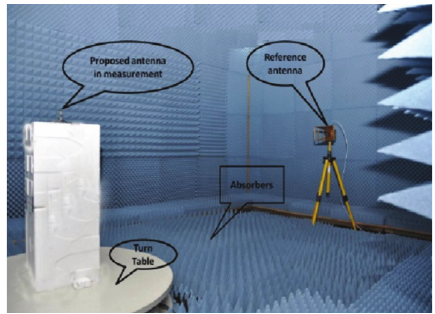
Figure 11: Anechoic chamber.